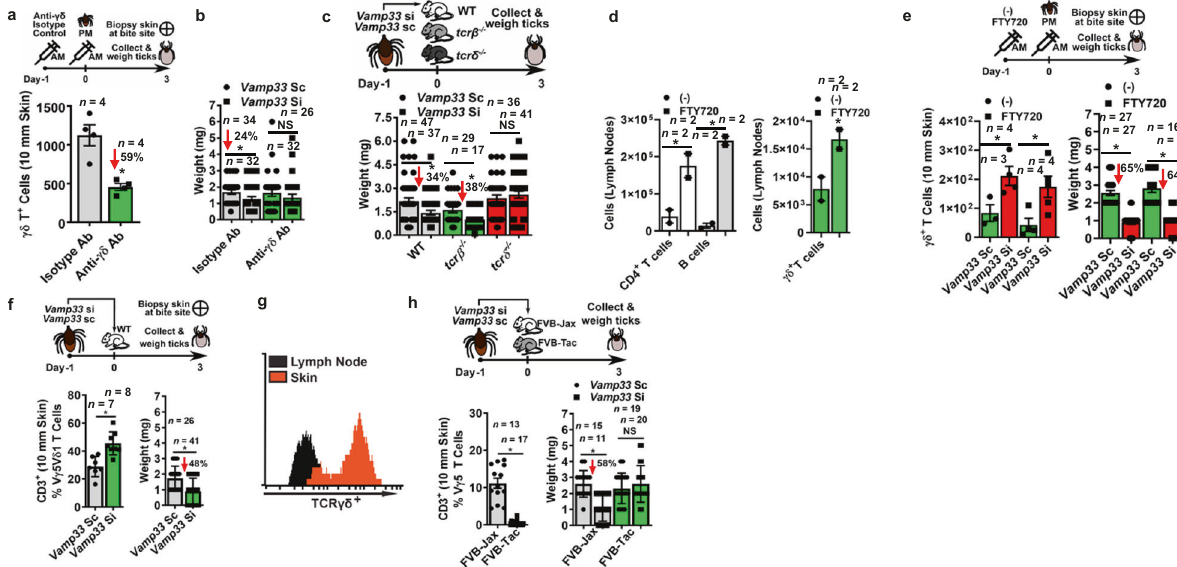
Fig. 4 Tick EVs affect DETCs in the murine skin. a Mice injected with anti- γδ antibodies (500 µ g) display decreased γδ T cells numbers at the skin site (right). The graph is representative of two independent experiments. b Vamp33 silencing (squares) resulted in similar tick bloodmeal intake when compared to the control treatment (circles) on γδ T cell-depleted mice (green). The graph represents two independent experiments combined. c Weight of Vamp33 si or Vamp33 sc ticks placed on wild type (WT; gray), tcr β − / − (green), and tcr δ − / − (red) mice for 3 days. The graph represents four